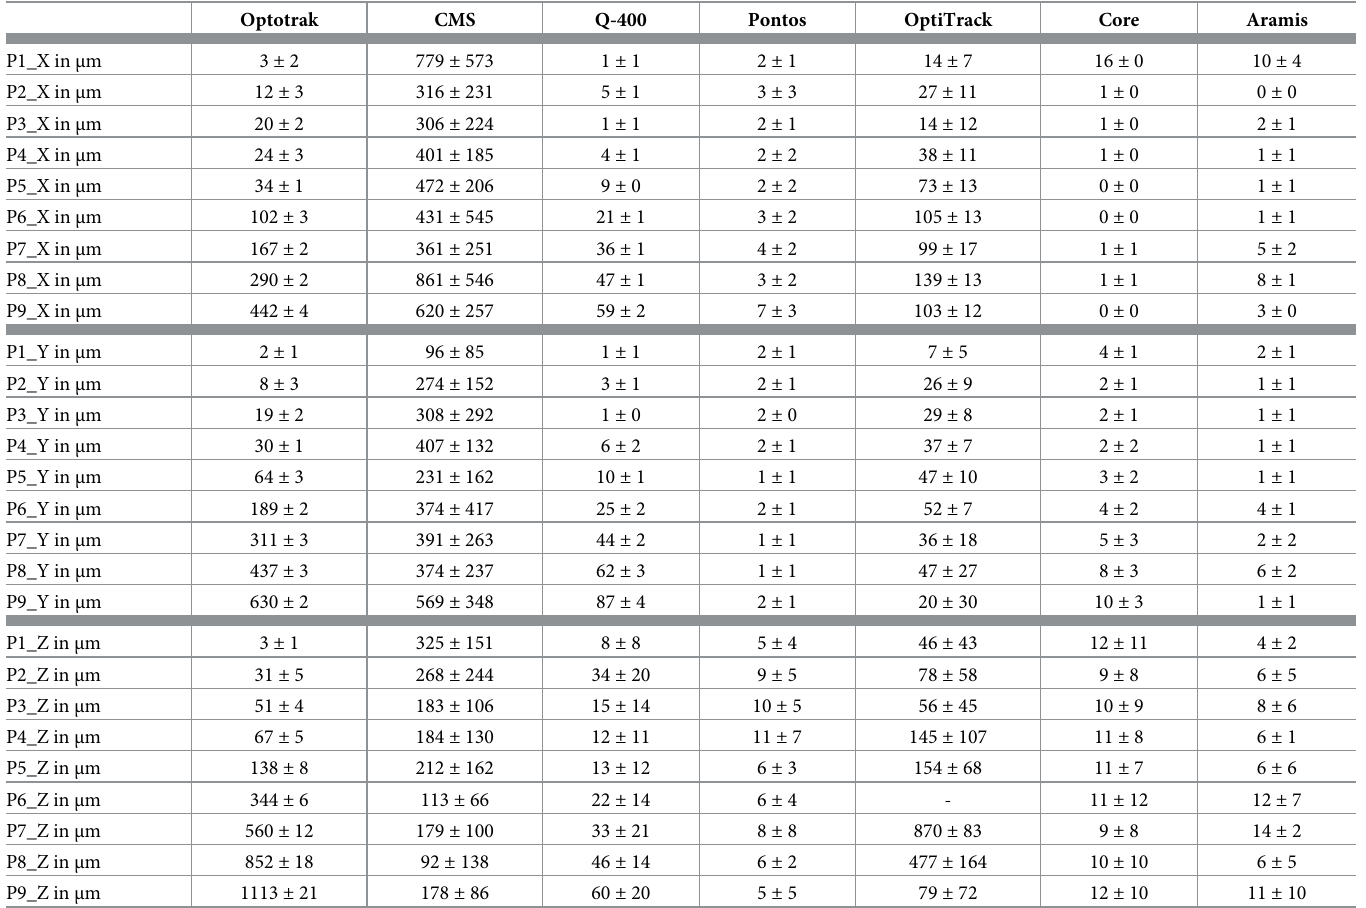
Table 5. Numerical measurement errors of the seven systems when using the CMM as reference